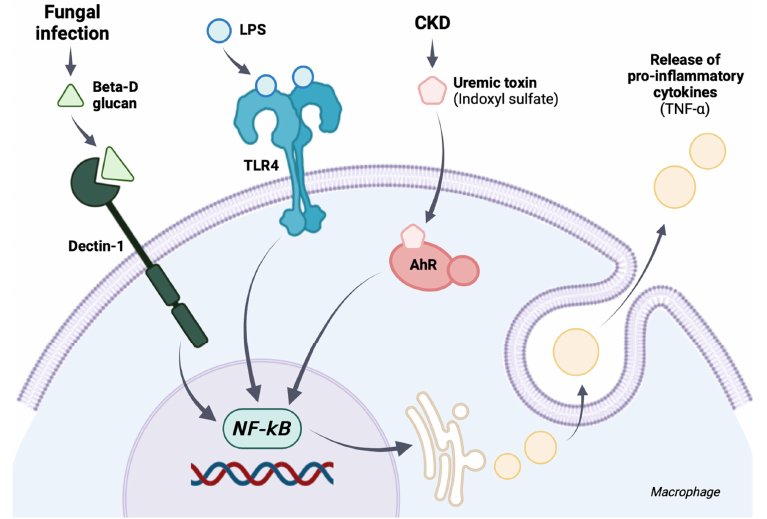
Figure 8. The proposed working hypothesis demonstrates the possible additional proinflammatory impact among lipopolysaccharide (LPS), (1 3)- β -D-glucan (BG), and indoxyl sulfate through NF- κ B transcription factor that is activated by TLR4, Dectin-1, and aryl hydrocarbon receptor.